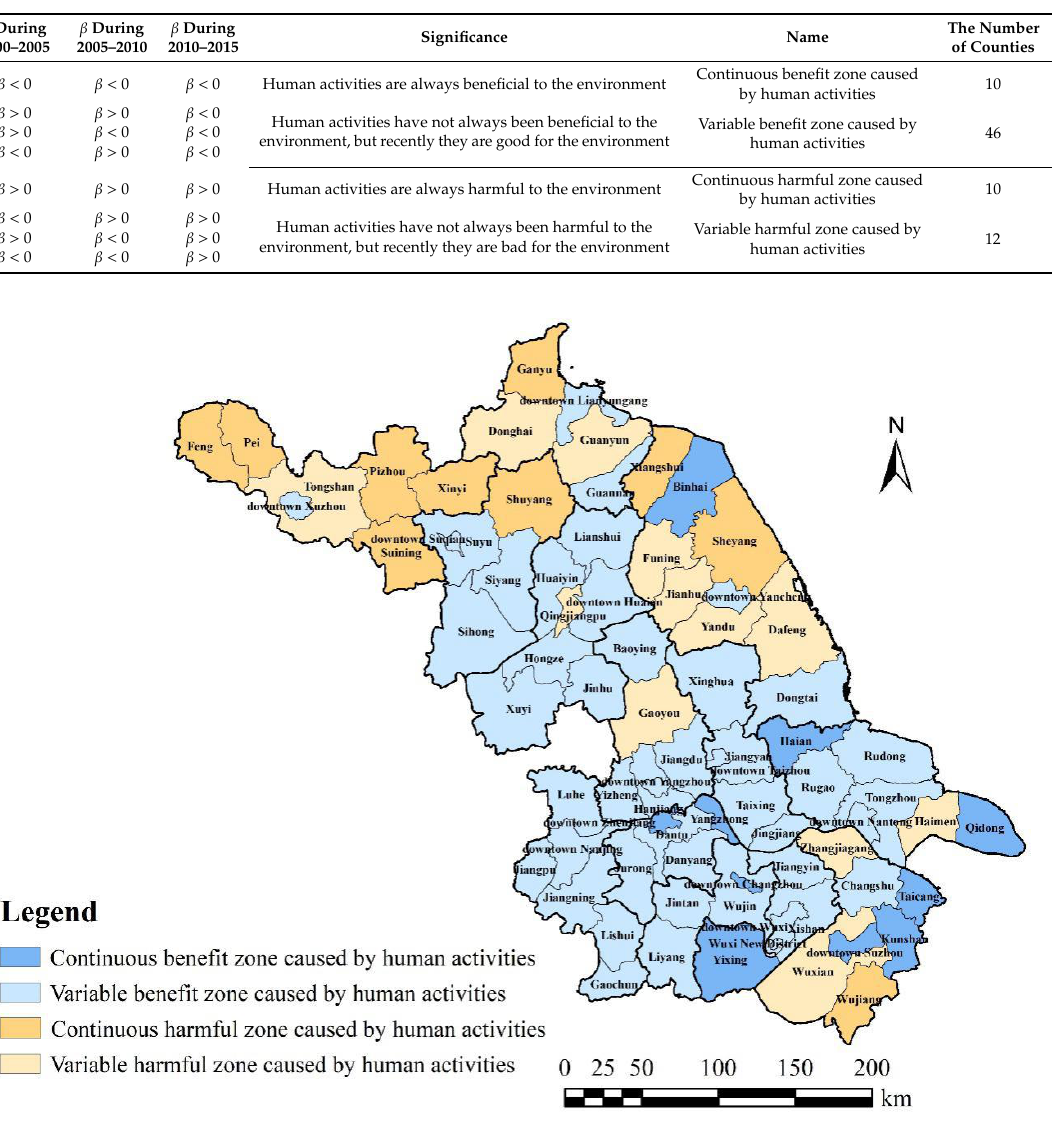
Figure 7. The result of spatial distribution according to the relationship between LVI and LHAI.